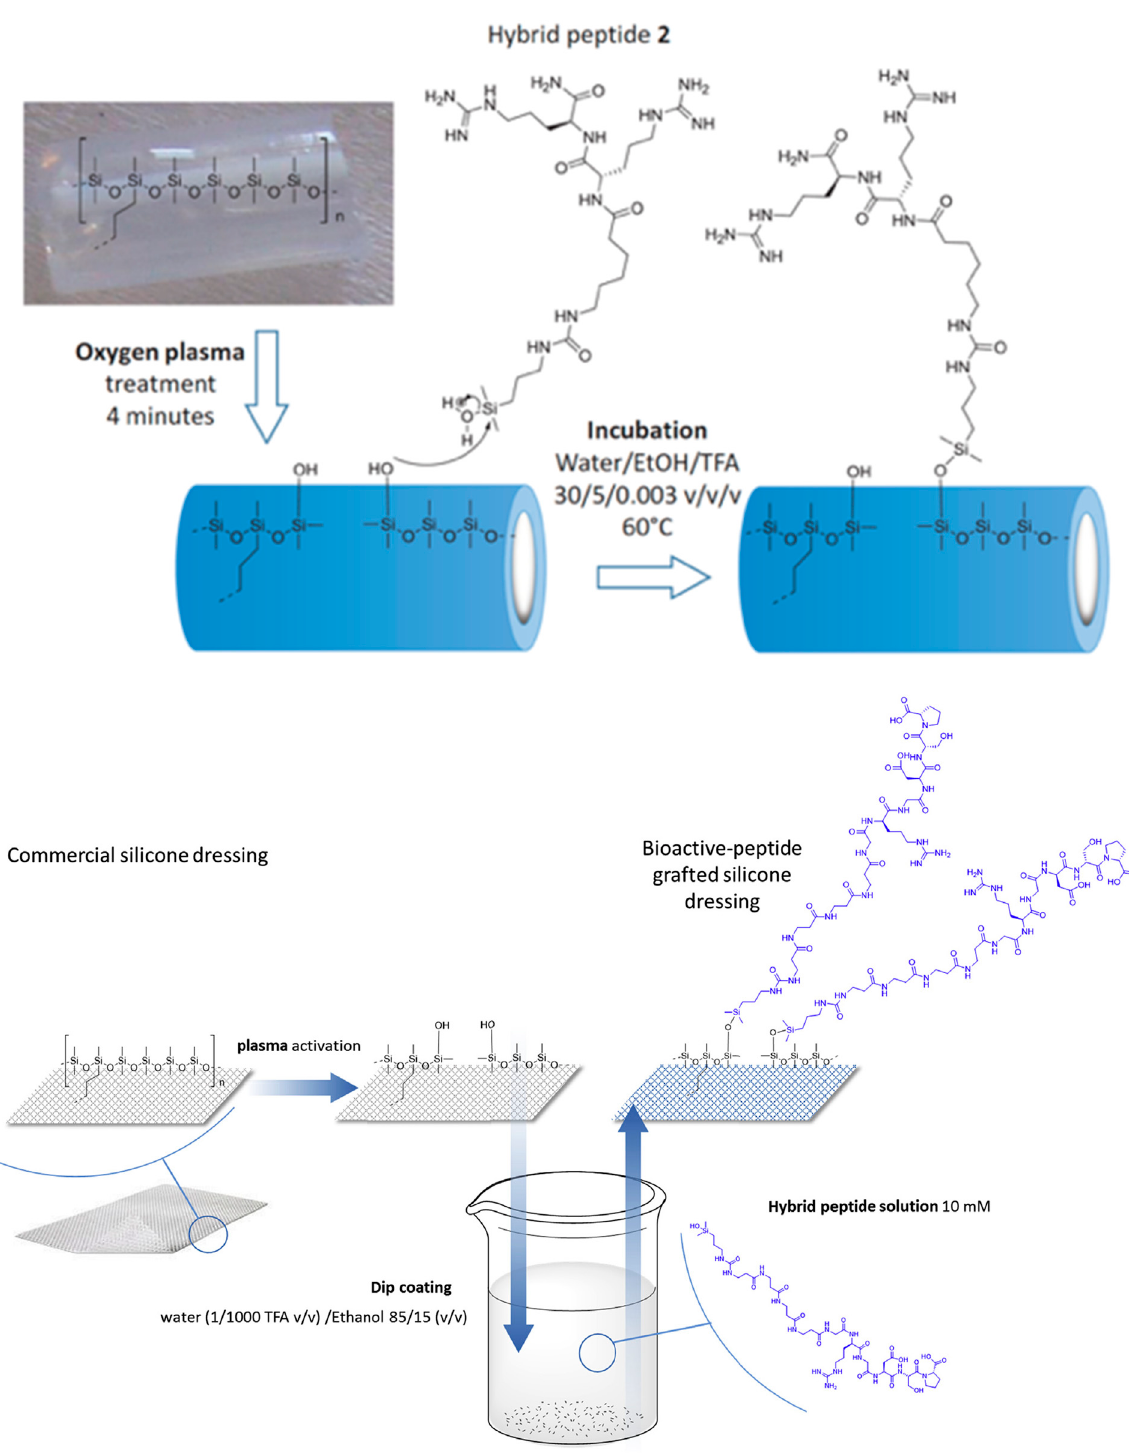
Figure 16. Grafting of AMP on activated silicone catheter ( top ) and on activated silicone dressing ( bottom ). For both strategies, the commercial silicone is activated by plasma before direct grafting of the modified peptide by a silanol group. Reproduced from [82,83]. Copyright © 2016 WILEY-VCH Verlag GmbH & Co. KGaA, Weinheim & Copyright © 2017 Elsevier Ltd. All rights reserved. This grafting process via covalent adsorption directly on the silicone surface led to a relatively low density of active peptides (~0.1 peptide/nm 2 of silicone on the catheter and ~0.4 peptide/nm 2 of silicone on the dressing). As a comparison, adsorption of antimicrobial peptides on gold surface functionalized by SAM was found to be ~1 peptide/nm 2 [94], and